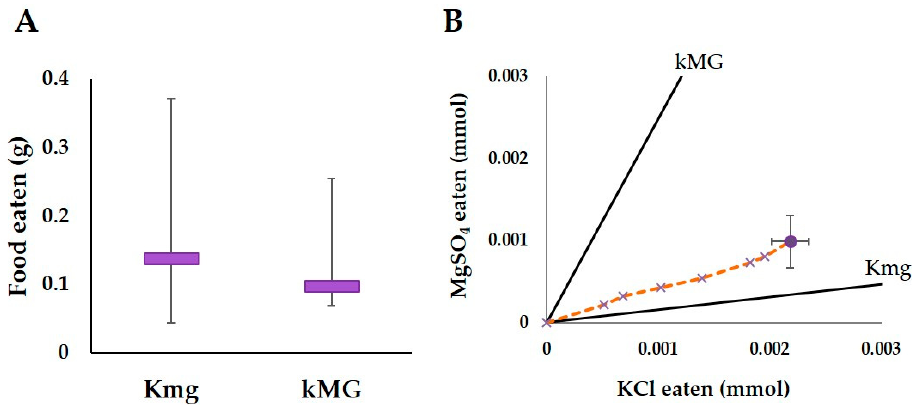
Figure 4. Results of the feeding trial in termites exposed to the food varying in MgSO 4 and KCl (Kmg and kMG diets). ( A ) Medians (purple bar) and quartiles (error bars) of the total amount of food eaten for all colonies (N = 10) after 14 days; ( B ) The nutritional intake of the termites for MgSO 4 and KCl over a 14 days period. The lines and symbols are the same as in Figure 2, except for the large circle and x’s are in purple and the nutrient rails represent the ratio of MgSO 4 and KCl in both food types.